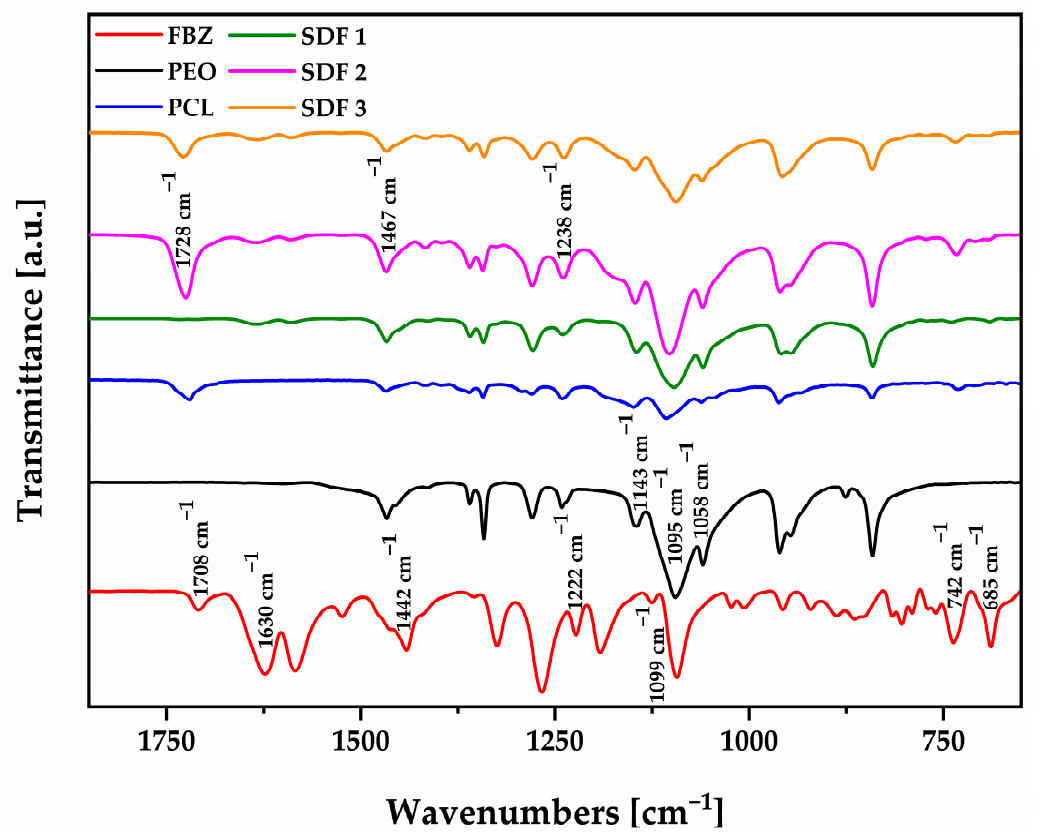
Figure 5. FTIR spectra of FBZ, PEO powder, PCL powder, SDF 1, SDF 2, and SDF 3.